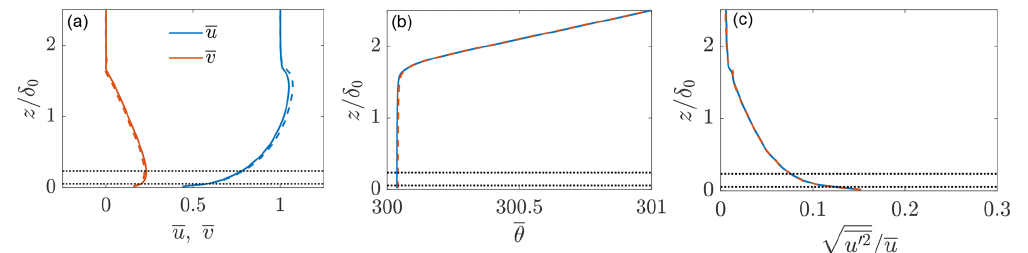
Figure 4. Horizontally averaged, concurrent precursor conventionally neutral ABL LES (a) velocity, (b) potential temperature in Kelvin, and (c) turbulence intensity. Horizontally averaged profiles from two different time instances are shown with solid (early) and dashed (late) lines, qualitatively demonstrating that the flow is statistically quasi-stationary (see further discussion by Howland et al., 2020a). Dashed-dotted lines show the extents of the turbine rotor